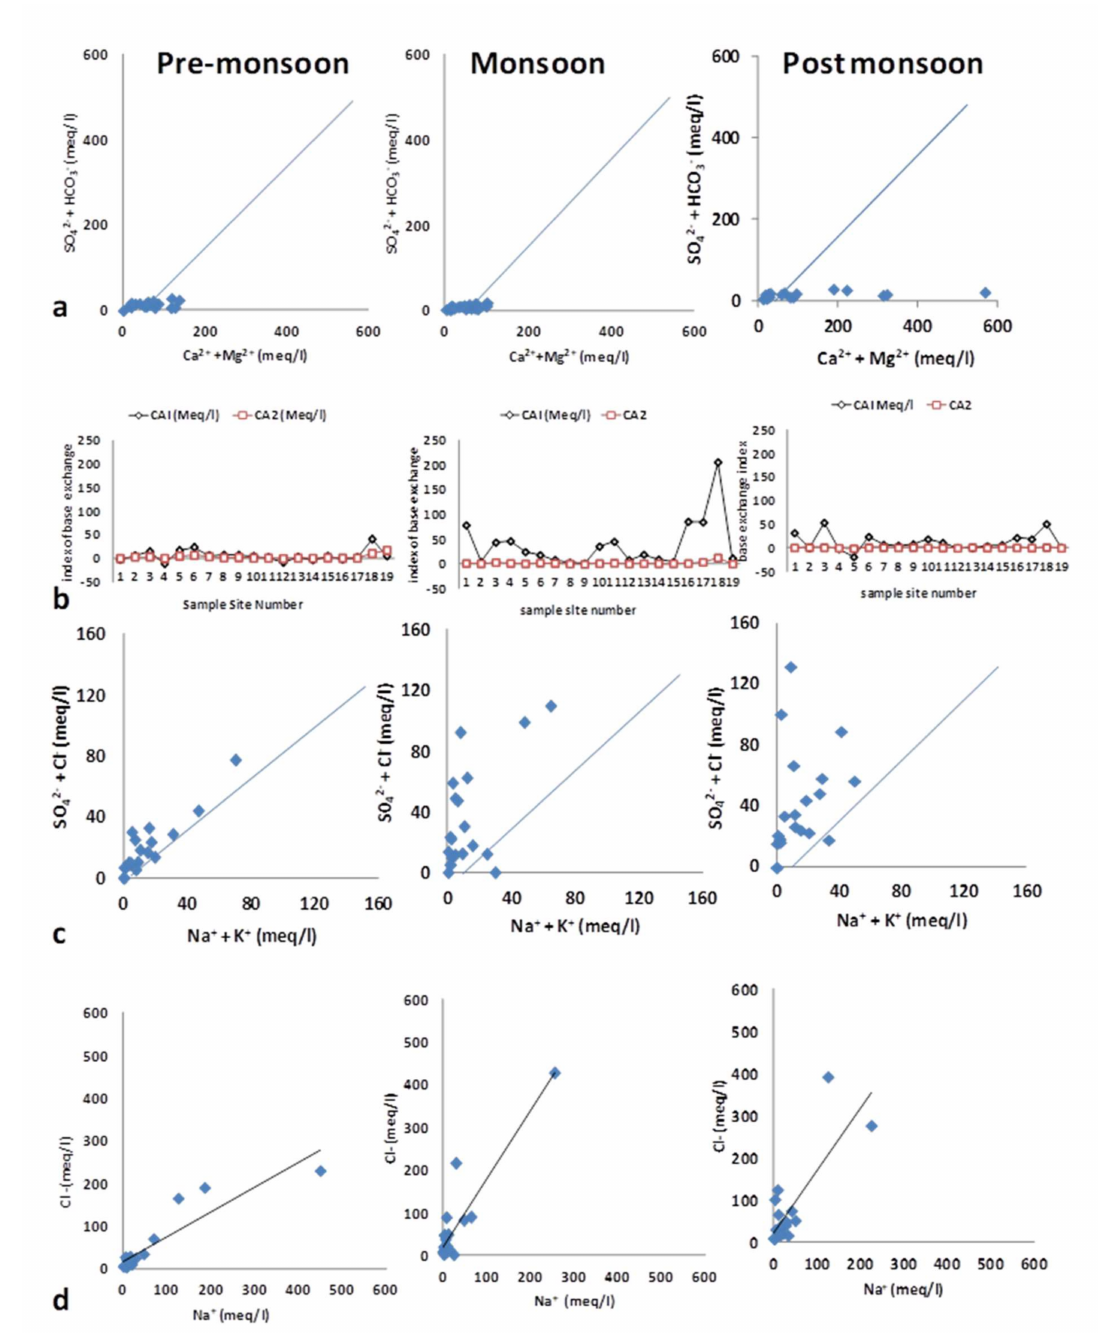
Figure 8. ( a ) Ca 2+ +Mg 2+ v/s SO 42 − + HCO 3 − ( b ) Base exchange indices ( c ) Na + + K + v/s SO 42 − + Cl − ( d ) Na + v/s Cl − for all 3